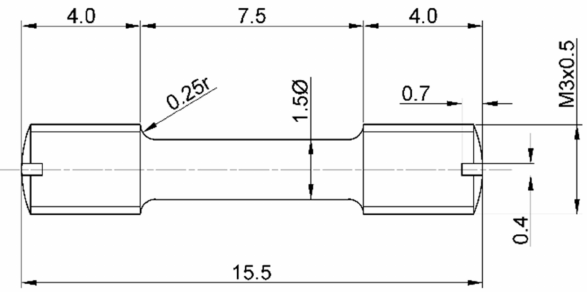
Figure 4. Shape and dimensions of sample for tensile microtesting.